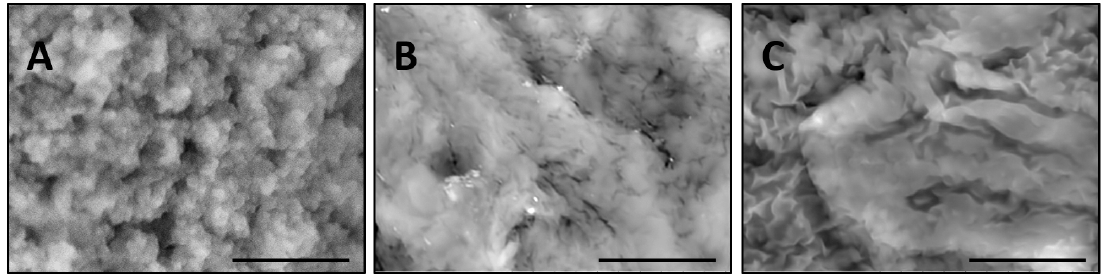
Figure 2. Comparison of the microstructures of bulk wet PNIPA-FA hydrogels prepared by thermal polymerization in water ( A ) or DMSO ( B ) and by UV polymerization in water ( C ) (scale bars = 5 µm).